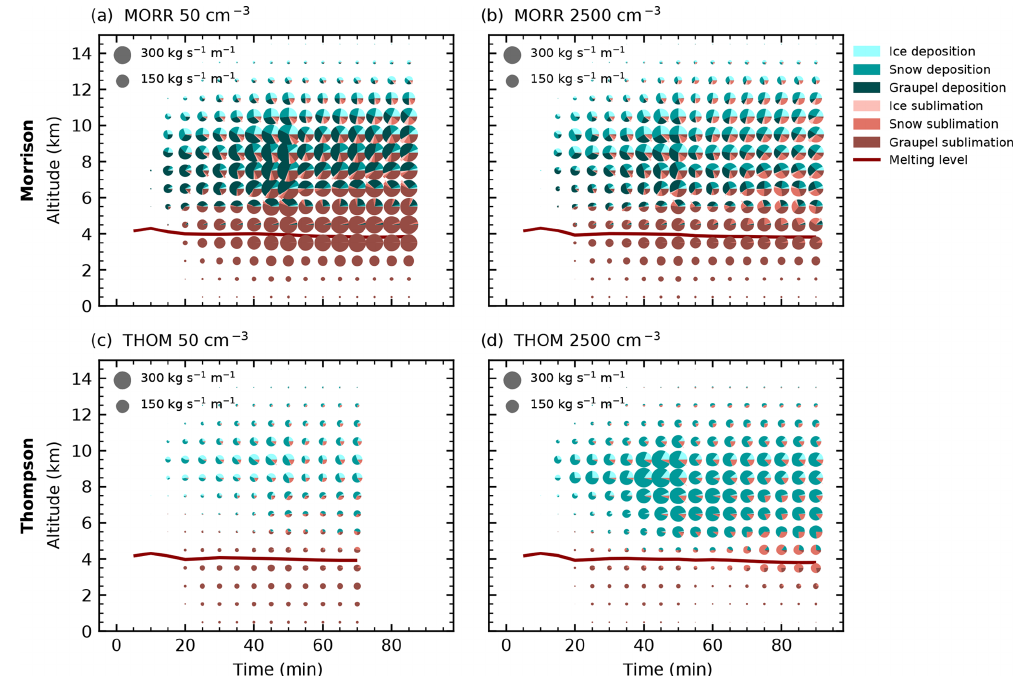
Figure 9. Time evolution of the microphysical process rates of deposition and sublimation as in Fig.